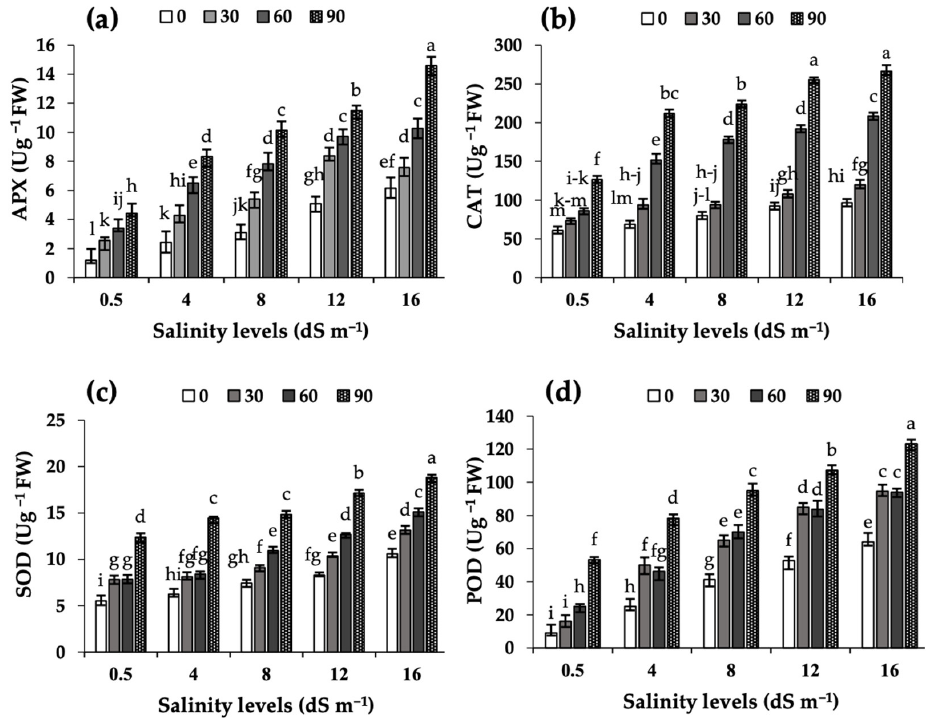
Figure 1. Effects of MEL foliar applications (0, 30, 60 and 90 µM) on APX ( a ), CAT ( b ), SOD ( c ), and POD ( d ) enzyme activities in leaf extracts of camelina grown under different levels of salinity (0.5, 4, 8, 12 and 16 dS m −1 ). APX: ascorbate peroxidase; CAT: catalase; SOD: superoxide dismutase, and POD: peroxidase. Data shown are means of three replicates per treatment ± SD. Different letters above the columns indicate statistically significant differences at p < 0.05.